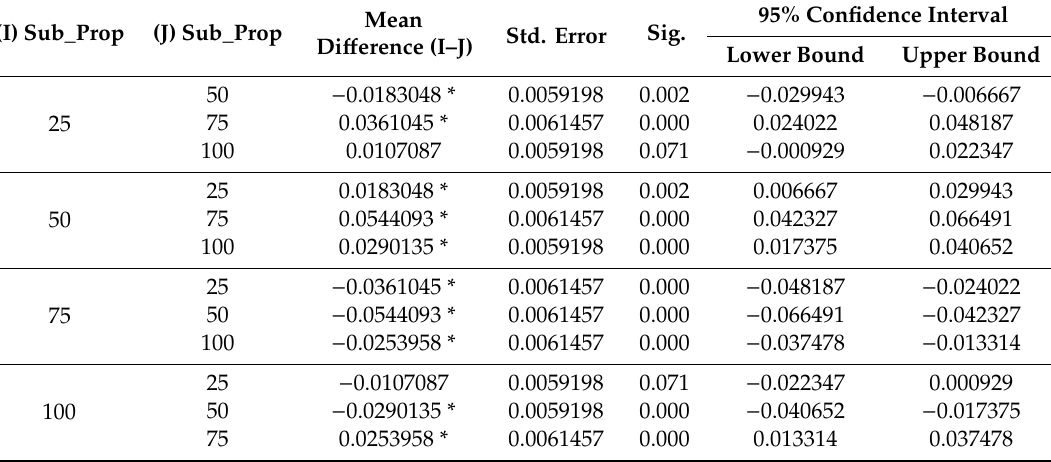
Table A2. Multiple Comparisons by the Least Significant Di ff erence (LSD) method for working voltages (V) generated by the microbial fuel cell (MFC) reactors with the cathode electrodes submerged at the proportions of 25%, 50%, 75%, and